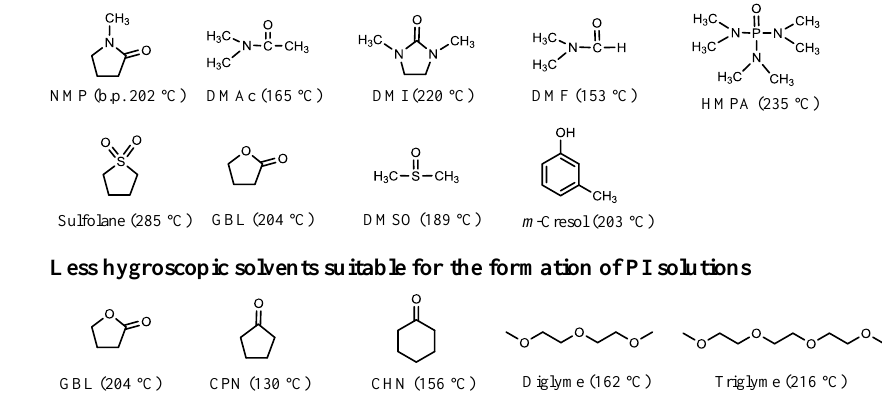
Figure 1. Polar solvents used for polymerization of PAAs and less hygroscopic solvents used for re- dissolution of chemically imidized powder samples. NMP = N -methyl-2-pyrrolidone, DMAc = N , N -